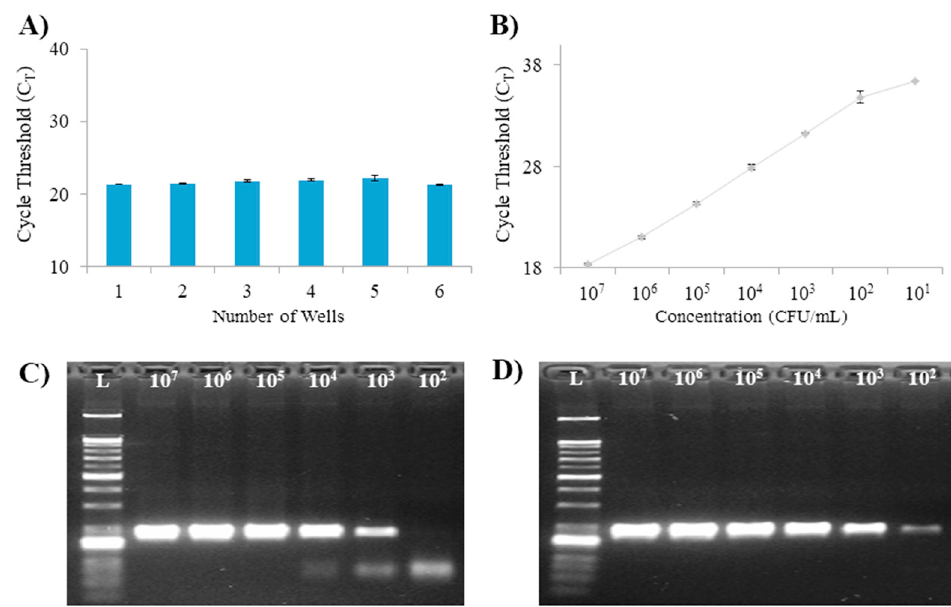
Figure 5. Evaluation of enrichment and extraction of several samples simultaneously in the 96-well filter/membrane plate (0.45 µm pore size, Hydrophilic PVDF membrane). ( A ) The cycle threshold (C T ) values of the DNA enriched and extracted using the AD–DMP filter plate (0.45 µm pore size, Hydrophilic PVDF membrane) system for a 1 mL sample of the same concentration. ( B ) Evaluation of the efficiency of the AD–DMP filter plate (0.45 µm pore size, hydrophilic PVDF membrane) system for samples diluted ( E. coli in PBS, 10 7 –10 1 CFU/mL). Error bars indicate standard deviation from the mean, based on at least three independent experiments. ( C ) Gel electrophoresis of PCR products using DNA extracted by repeated enrichment of 1 mL samples using commercial QIAamp DNA Mini Kit (spin column, DNA Mini Kit: Cat No. 51304, Qiagen, Hilden Germany) and Centrifuge. ( D ) Gel electrophoresis of PCR products using DNA extracted by repeated enrichment of 1 mL samples using the AD–DMP filter plate (0.45 µm pore size, Hydrophilic PVDF membrane) system. Table 2. Comparison of extraction efficiencies of AD-DMP filter and column based kit. Concentration of E. coli